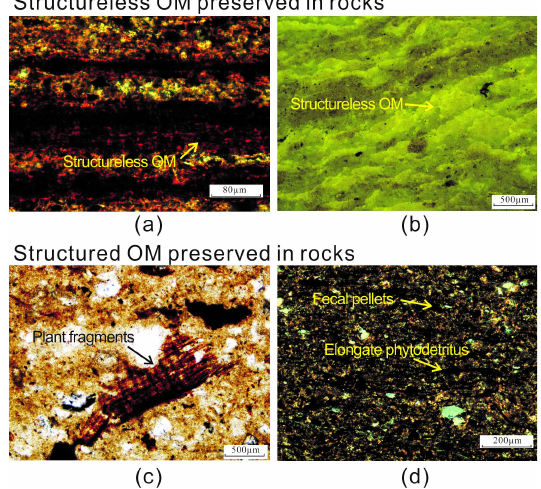
Figure 7. Characteristics of various types of OM preserved in rocks. Structureless OM preserved in ( a ) Organic-rich laminae and ( b ) Micritic laminae (under fluorescent light). Structured OM in rocks preserved as ( c ) Higher plant fragments and ( d ) Elongated and flattened phytodetritus and microfossils of fecal